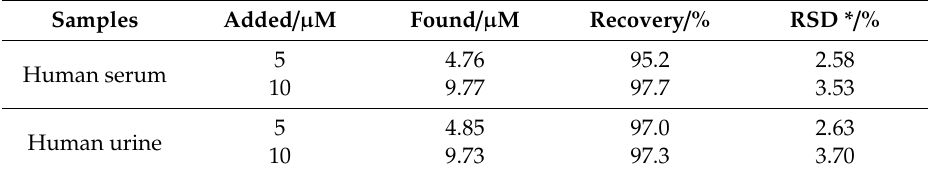
Table 4. Determination of spiked FA in biological samples using GCE / rGO / PDA / AuNPs. Samples Added / µ M Found / µ